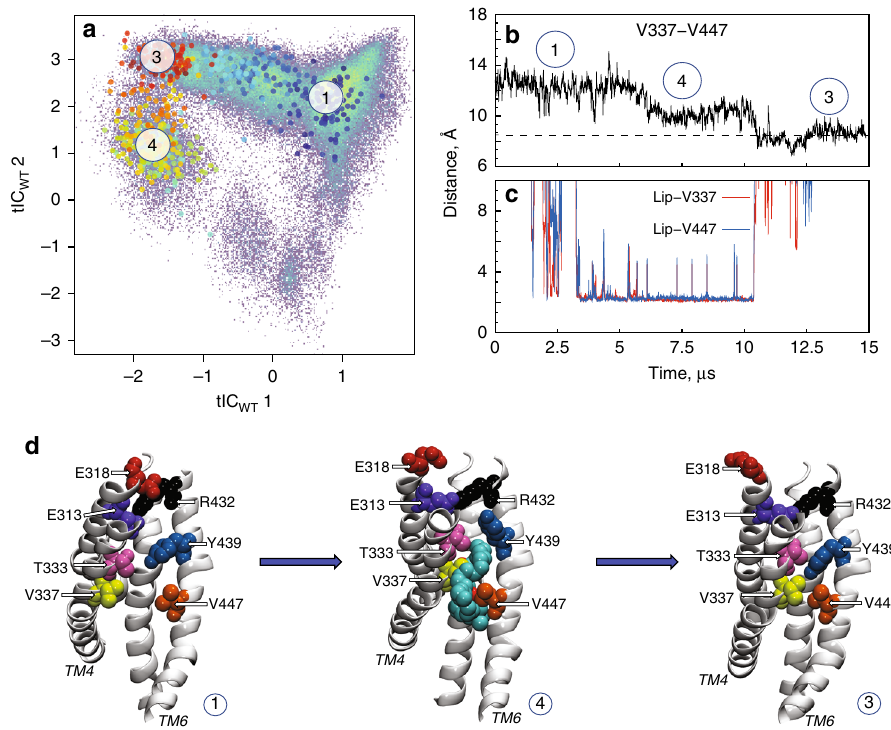
Fig. 2 The time evolution of an MD trajectory shows that occlusion of the groove is triggered by lipid tail insertion. a Projection (large colored dots) of the 15 µ s-long WT6 MD trajectory calculated for one of the nhTMEM6 subunits on the 2D tICA landscape from Fig. 1. The colors of the large dots indicate the time-frames in the evolution of the trajectory: darker colors (blue, cyan) are indicating the initial stages of the simulation, lighter colors dots (yellow, green) correspond to the middle part of the trajectory, and red shades show the last third of the trajectory. In this representative trajectory the system is seen to have evolved from microstates 1 to 4, and to 3. b The evolution of the C α -C α distance between residues V337 and V447 as a function of time in the WT6 trajectory. c Time evolution of the minimum distance between the lipid tail penetrating the groove and residues V337 (in red) and V447 (in blue). d Structures of representative snapshots showing the gradual occlusion of the groove in going from microstate 1 to 4 and to 3. The color code in ( d ) is the same as in Fig. 1a; TM4 and TM6 are labeled. Note that the lipid tail present inside the groove in microstate 4 is absent in the ensemble of states in microstate 3, suggesting that once the occluding con fi guration was established, the lipid tail is no longer necessary for its relative stability